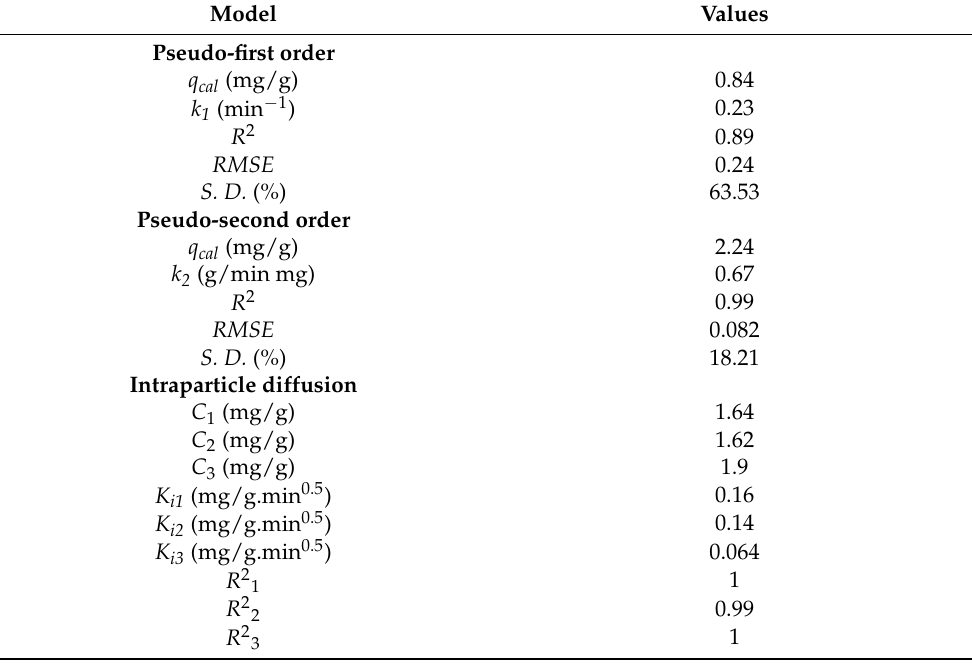
Table 4. Kinetic model parameters for adsorption of F − by